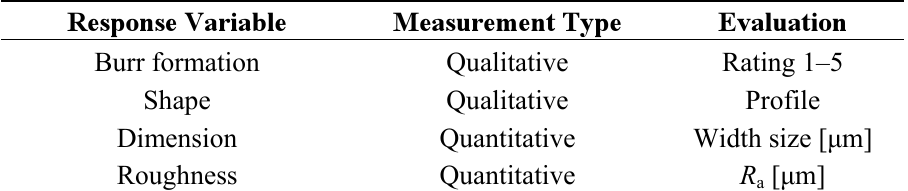
Table 3. Metrology response